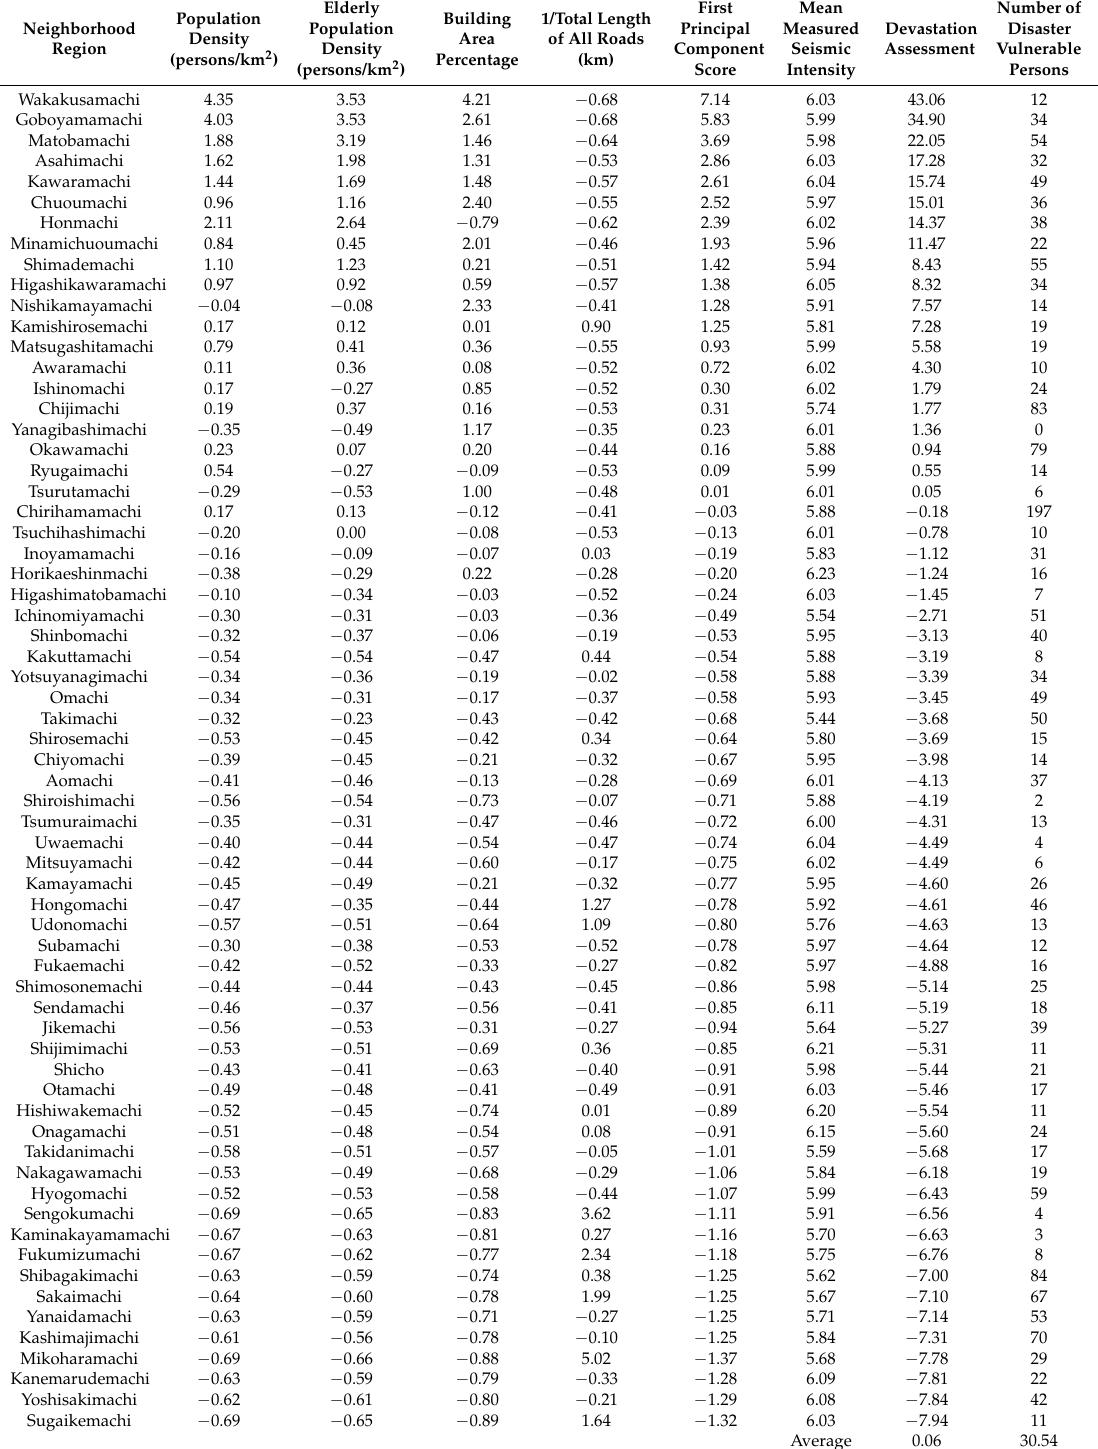
Table 2. Each analysis result and devastation assessment in each neighborhood, and the number of disaster-vulnerable